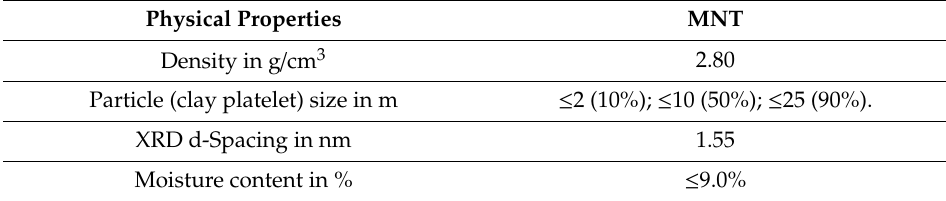
Table 1. Montmorillonite (MNT) physical properties. XRD, X-ray di ff raction; CS-15A, cloisite-15A.